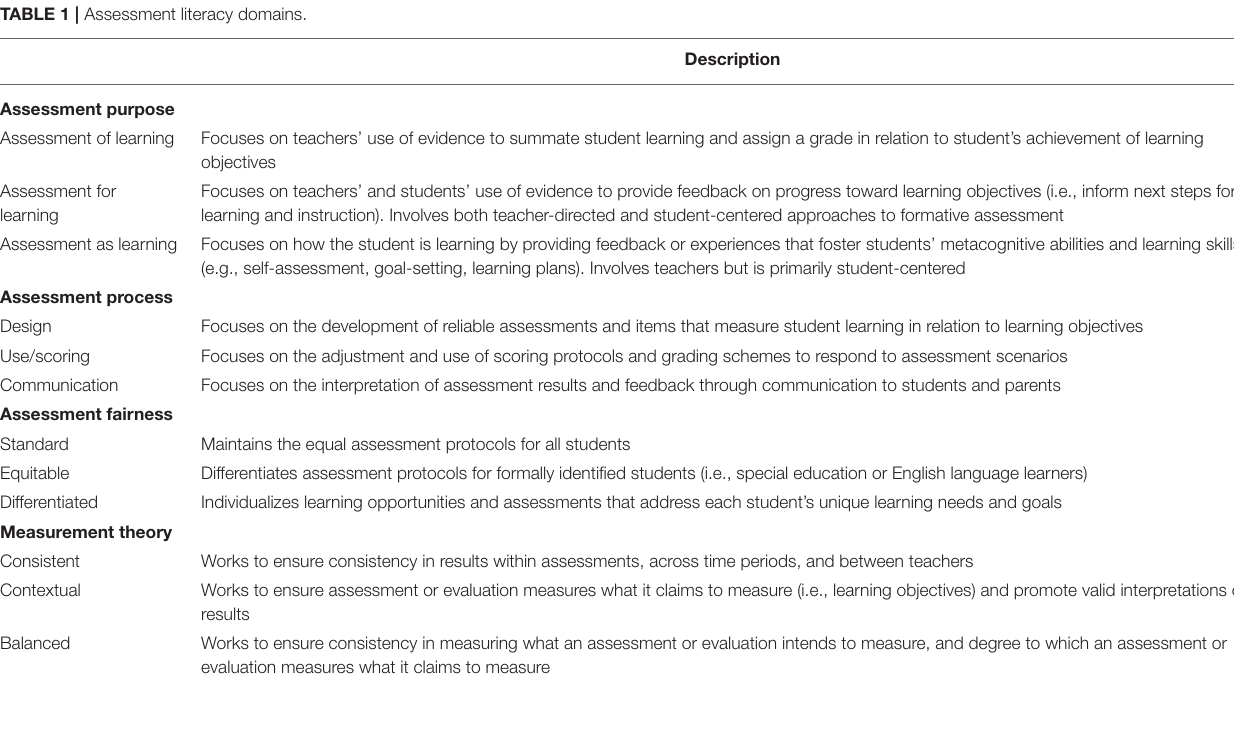
TABLE 1 | Assessment literacy